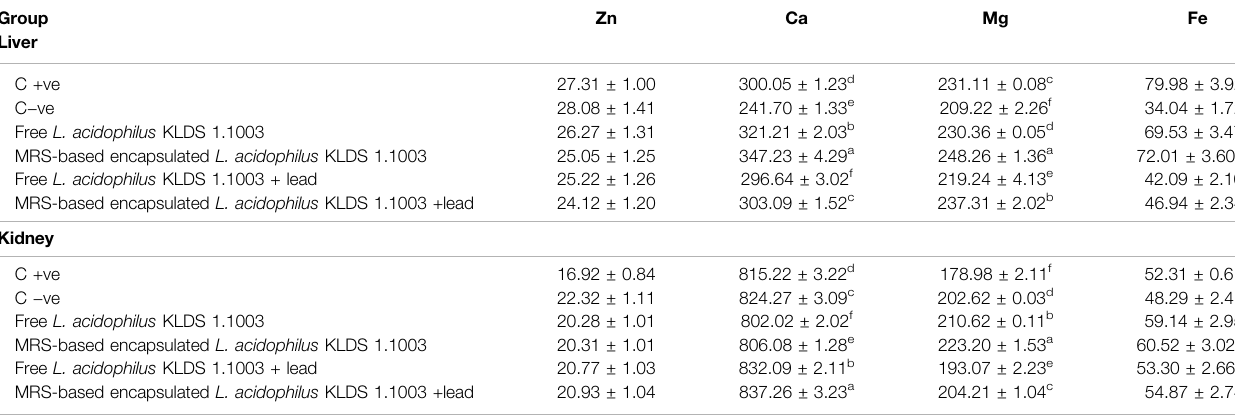
TABLE 4 | Effects of nonencapsulated and MRS-based encapsulated L . acidophilus 1.1003 on metal levels in the livers and kidneys of